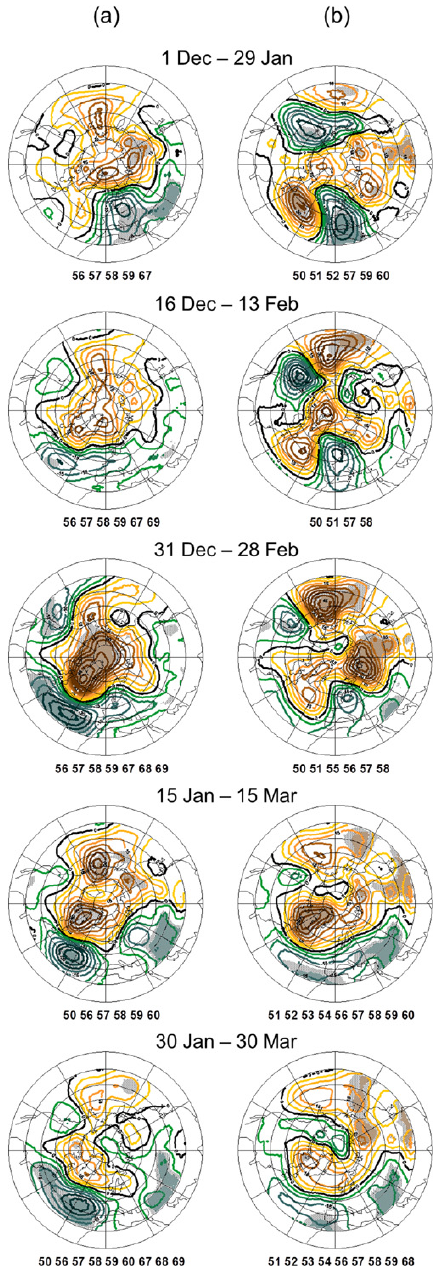
Fig. 1. Stratosphere in the years 1950–1969. Composite maps of 60-day winter (December–March) mean values of GPH anoma- lies at the geopotential level of 20hPa under: (a) high solar activ- ity ( R ≥ 100) and (b) high geomagnetic activity ( 6 Kp ≥ 20). GPH anomalies were computed from the long-term (1950–2002) aver- age. The caption above each map indicates the beginning and end of the selected period. The pairs of numbers below each map indi- cate the year in which the particular 60-day period started. Positive anomalies are plotted as yellow-brown lines and negative anomalies as green-blue lines. The contour interval is 30m. Shadings indicate areas where the Monte Carlo test introduced in Sect. 2 gave highest score.